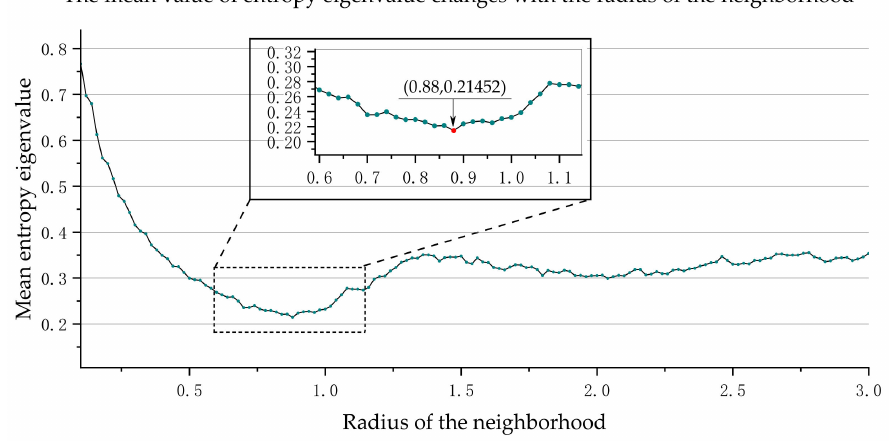
Figure 9. The mean entropy eigenvalue of 100 m OCS point cloud changes with the radius of the